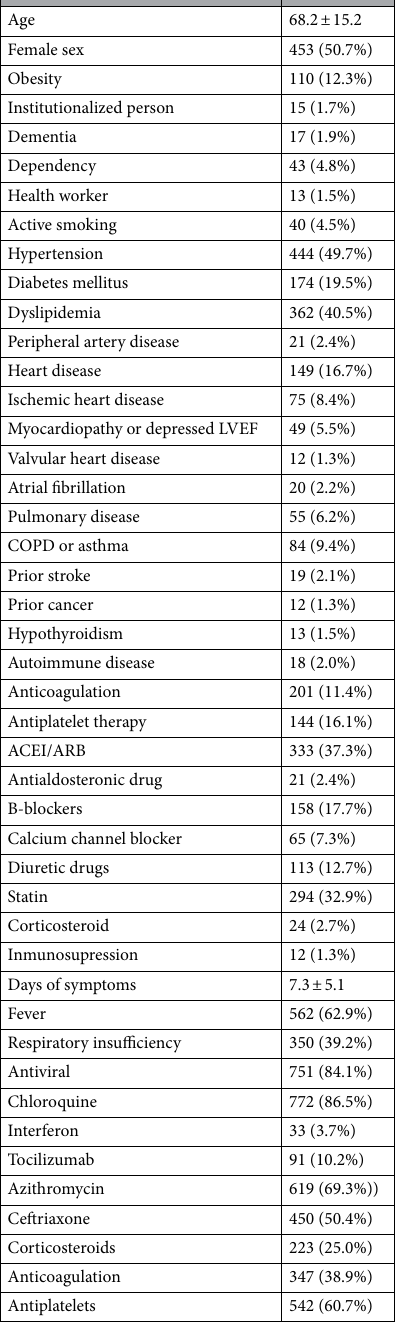
Table 1. Baseline characteristics of total population (n = 893). Categorical variables in n (%) and quantitative variables in mean ± standard deviation. LVEF left ventricle ejection